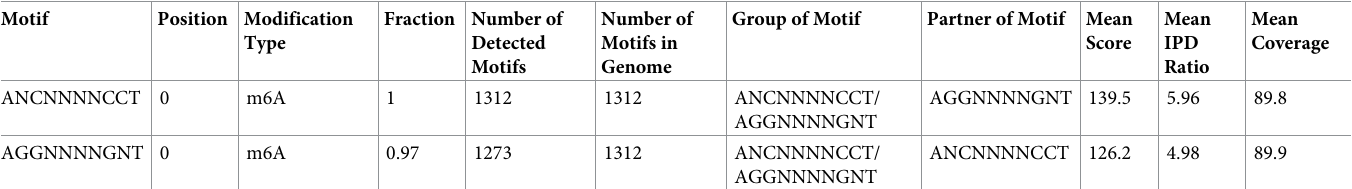
Table 1. Characteristics of the modification motif ANCNNNNCCT. Mean Score–mean Modification QV of instances of this motif that were detected as modified; Mean IPD Ratio–mean interpulse duration (IPD) ratio of instances of this motif that were detected as modified; Mean Coverage–mean coverage of instances of this motif that were detected as